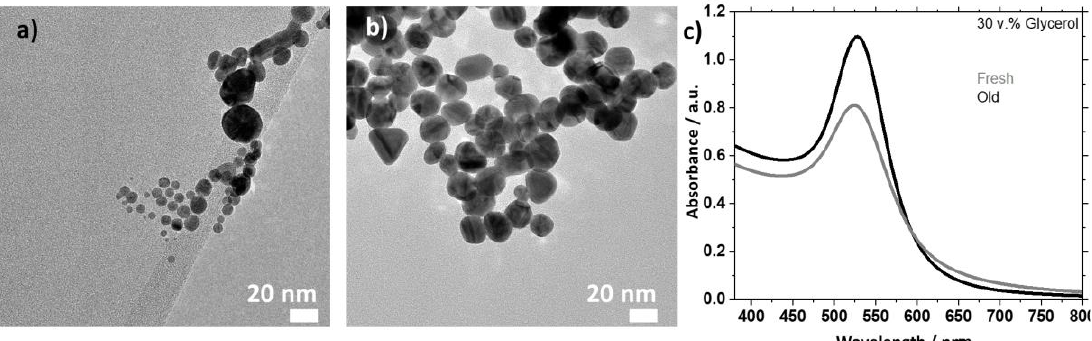
Figure 4. Characterization of Au NMs obtained a surfactant-free RT synthesis using 30 v.% ( a – c ) glycerol as reducing agent. ( a , b ) TEM micrographs of samples prepared using ( a ) a fresh or ( b ) an old stock solution of NaOH and ( c ) UV-vis characterization of the samples, as indicated.